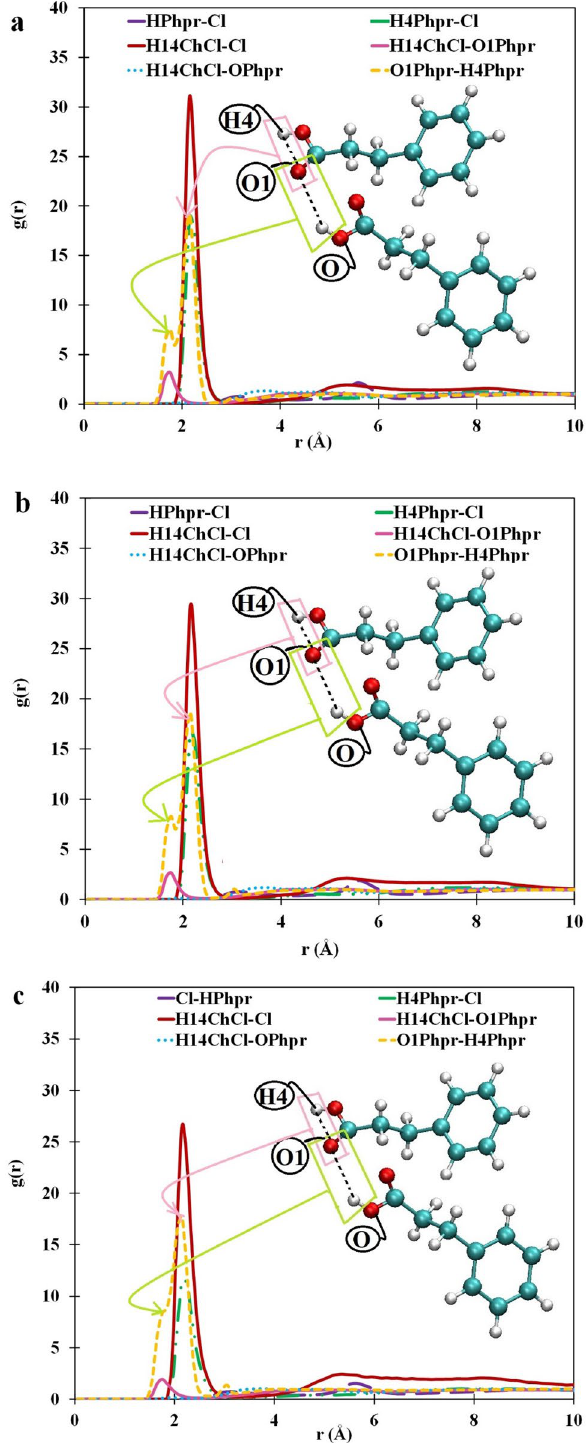
Figure 2. Atom–atom RDFs for Phpr–Phpr (yellow), Phpr-choline (blue and pink), Phpr–Cl − (green, violet), and choline-Cl − (red) at ( a ) 293 K, ( b ) 321 K and ( c ) 400 K were obtained using the VMD package 40